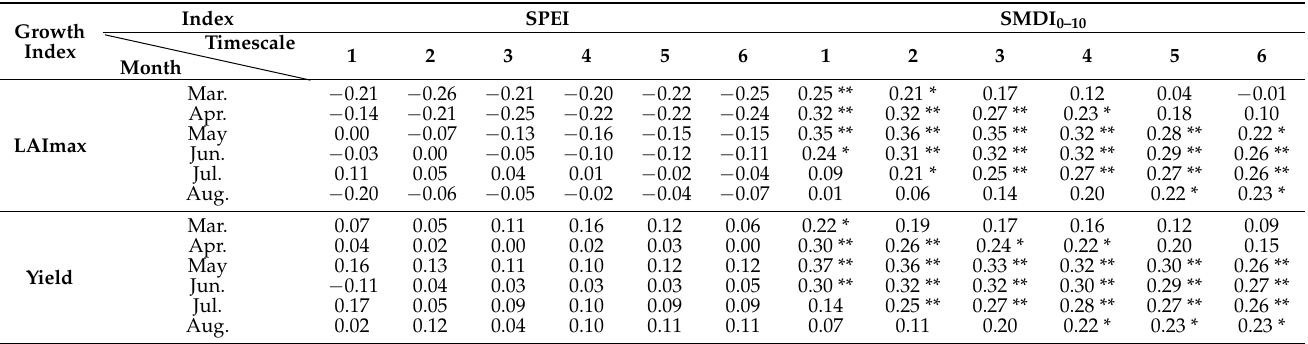
Table 4. The correlation coefficient values between spring wheat yield (LAI max ) vs. multi-scalar SPEI and SMDI 0–10 , The numbers 1–6 indicate the timescale of drought index from 1 to 6 months, respectively. (** represents p -value ≤ 0.05, and * represents p -value ≤